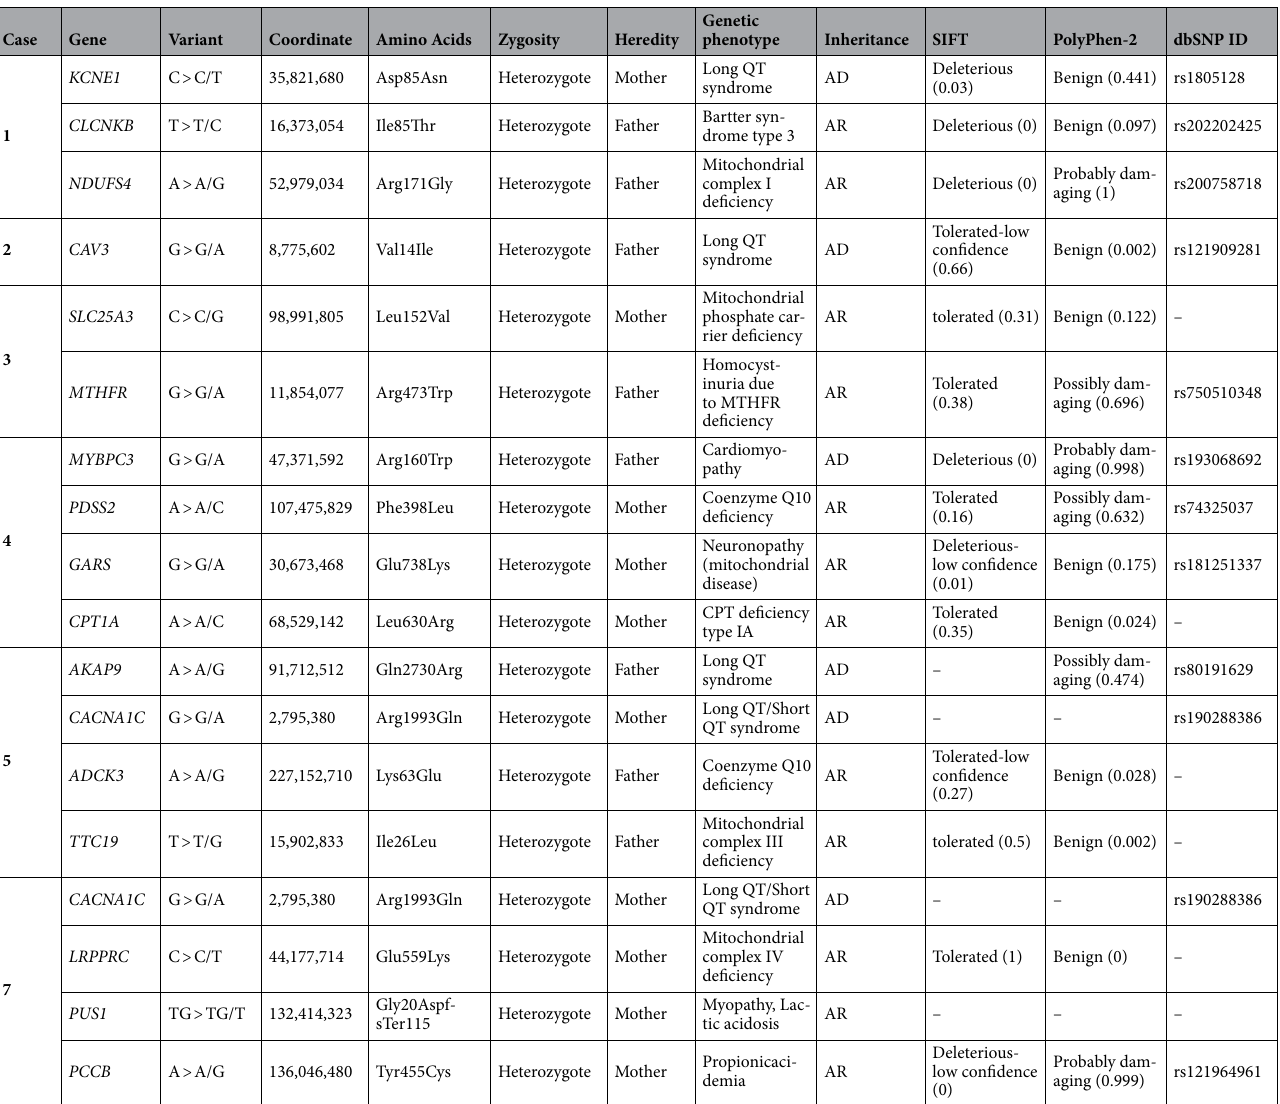
Table 3. Results of known arrhythmia-, inherited metabolic disease-, mitochondrial disease-, and salt- losing tubulopathy-related variants. MTHFR: methylenetetrahydrofolate reductase, CPT: carnitine palmitoyltransferase, AD: autosomal dominant, AR: autosomal